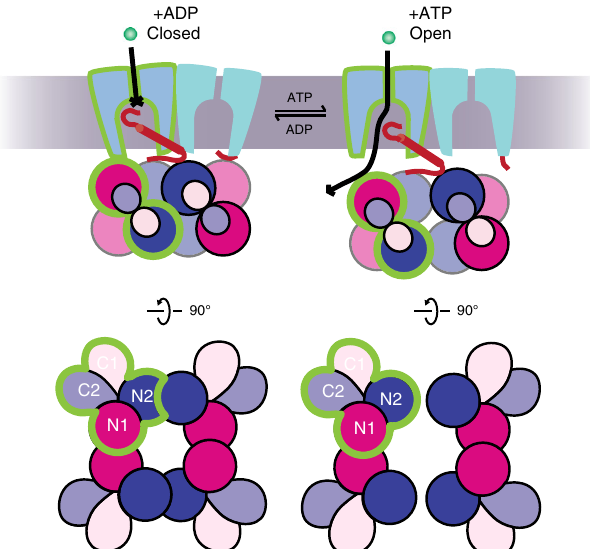
Fig. 8 Proposed gating mechanism of TrkHA. Upper: Cartoon illustration of TrkHA in the closed (left) and open (right) states viewed within the plane of the membrane (gray). Teal and cyan: TrkH; blue: N2 domain; purple: N1 domain; light blue: C2 domain; and light purple: C1. The green outlines mark one TrkH and one TrkA protomer. Lower: the tetrameric TrkA ring in the presence of ATP (left) and the two TrkA dimers in the presence of ATP (right). In the presence of ADP, TrkA forms a tetramer and closes TrkH through interactions at both the HN1 and HN2 interfaces. In the presence of ATP, the tetrameric TrkA gating ring is split into two dimers. Opening of a TrkH channel is achieved by the downward movement of the N2 domains away from the membrane that in turn moves the intramembrane loop from blocking the selectivity fi lter, and by distruption of the HN1 interfaces that allows dilation of the pore-lining helices. The two TrkH protomers also rotate relative to each other during the gating